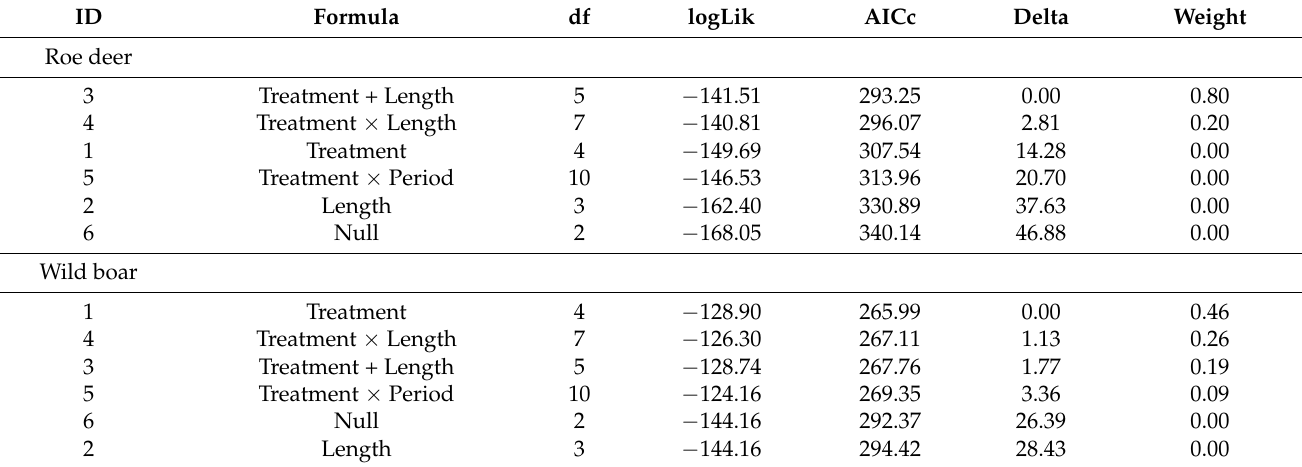
Figure 2. ( a ) Roe deer: flight probability across treatments and correlations between flight probability and time length of experiment; ( b ) wild boar: flight probability across treatment. Shaded areas and vertical bars indicate the 95% confidence intervals of the predicted values. Table 2. Rank of logistic regression models for flight probability of roe deer and wild boar based on AICc.